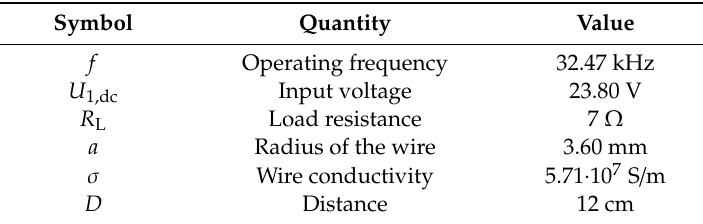
Table 1. Parameters of the MCR-WPT